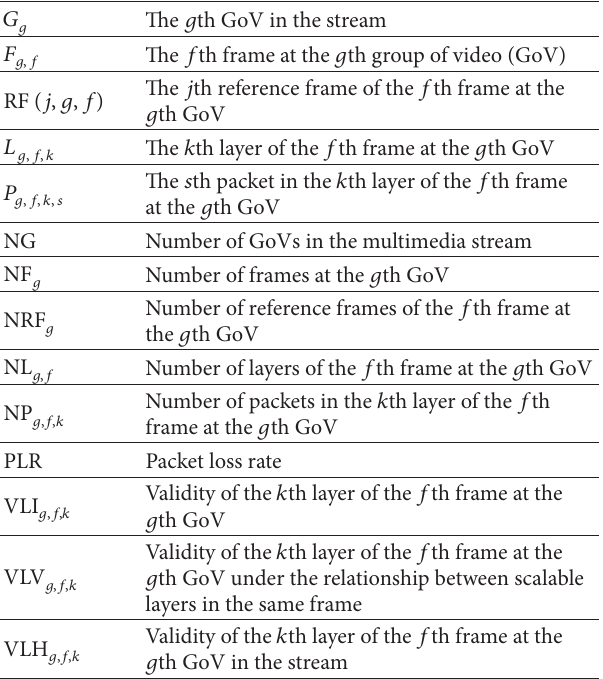
Table 1: Scalable streaming conversion